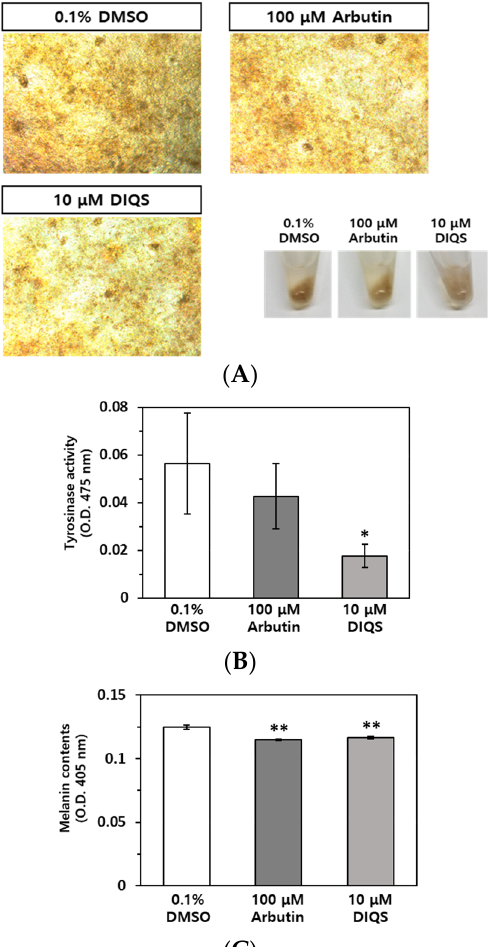
Figure 3 . DIQS treatment inhibited melanin synthesis in pigmented human skin tissue. ( A ) Repre- sentative images of cultured human skin tissue. Melanin pellets were prepared as described in the Materials and Methods, and photographs were taken prior to measurement of melanin content. ( B ) Melanin content in the Neoderm-ME model was inhibited by 10 μ M DIQS. ( C ) Tyrosinase activity in the Neoderm-ME model was inhibited by 10 μ M DIQS. Data are means ± SD. * p < 0.05 and ** p < 0.01 (vs. the α -MSH-treated group).